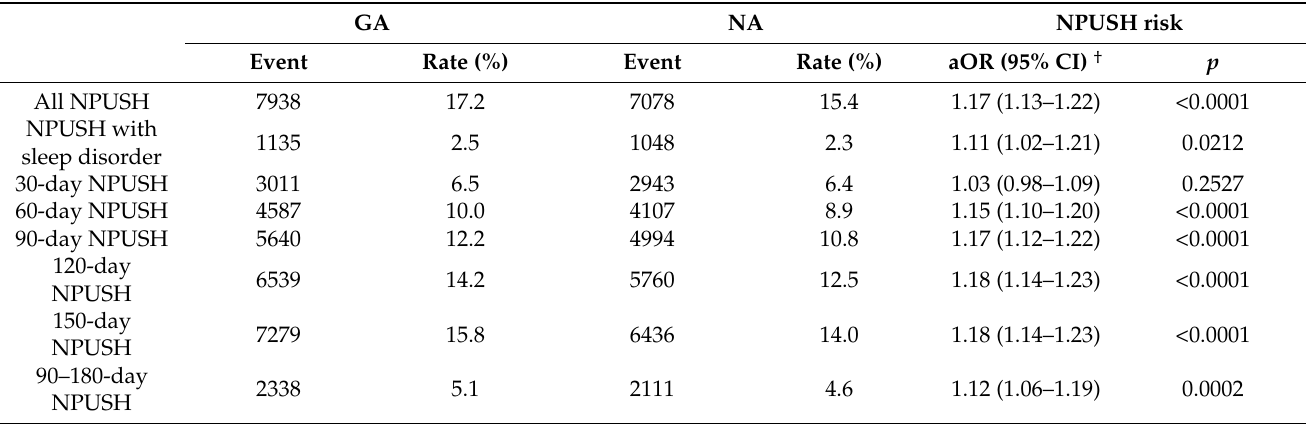
Table 3. New postoperative uses of sedative–hypnotics for patients undergoing general or neuraxial